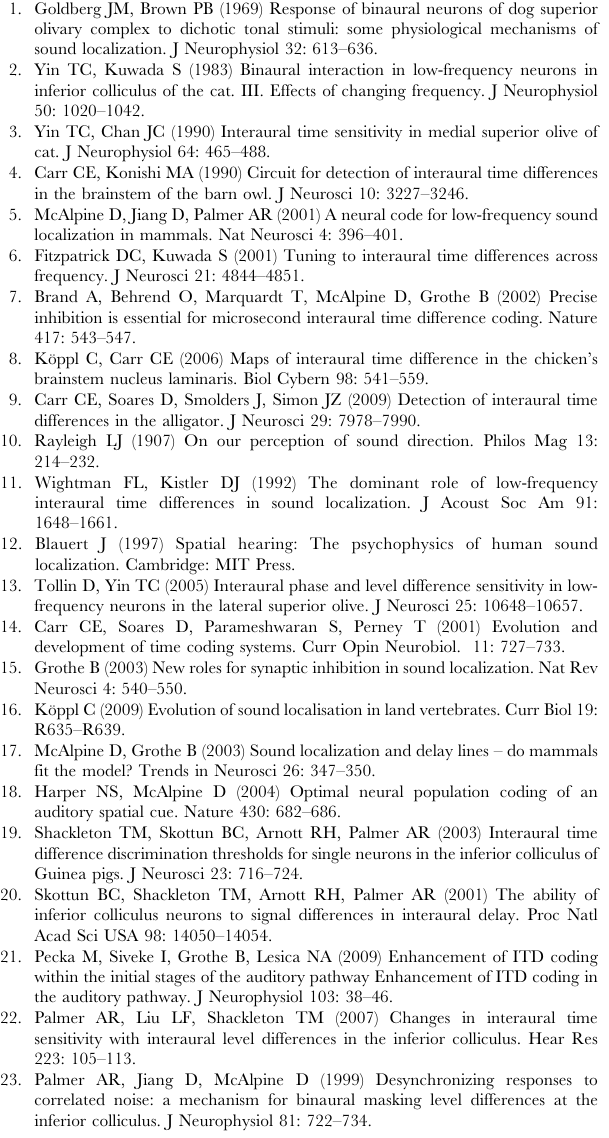
(black) obtained by randomly generating spike counts from a Gaussian distribution with cell-specific mean and variance. (B,C) Four surrogate spike counts (like in A) were generated for each cell and used to derive cell-wise standard errors of the mean (SEM) for CP and CD | BF . (B) Cumulative distribution of SEM for CP ( N ~ 66 cells). Vertical lines indicate the SEM values of about 0 : 023 cyc . and 0 : 049 cyc . at the 67% and 90% quantile, respectively. (C) Same as B for CD | BF , with SEM